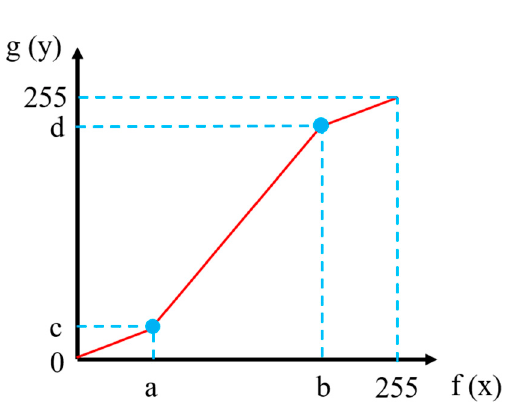
Figure 5. The schematic diagram of piecewise linear stretching. Here, f(x) represents the grayscale value of the original image; a and b represent the segment transformation points in the original image; g(y) represents the grayscale value after image enhancement; c and d represent the segment point after enhancement.